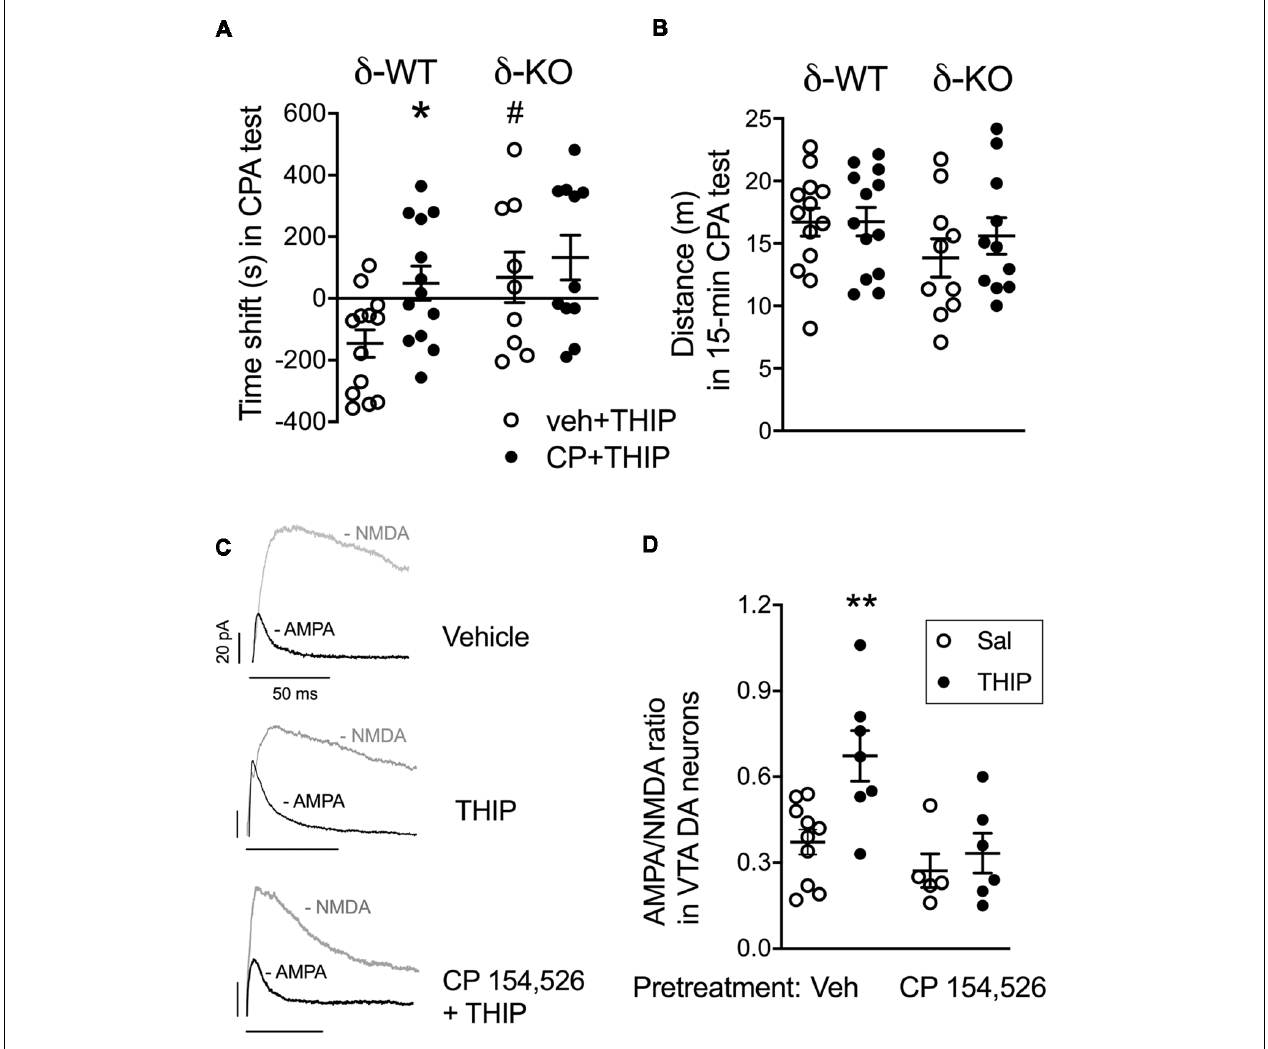
FIGURE 2 | Pretreatment with corticotropin-releasing factor receptor 1 (CRF 1 ) receptor antagonist, CP 154,526, attenuated THIP-induced conditioned place aversion and glutamate neuroplasticity in ventral tegmental area (VTA) dopamine (DA) cells. (A) Vehicle-pretreated δ -WT mice conditioned with THIP expressed place aversion (spent less time with initially non-preferred floor mats) at 48h after the last conditioning session, while those conditioned after CP 154,526 pretreatment failed to express any preference or aversion. The δ -KO mice conditioned with THIP failed to express aversion independent of the pretreatment. (B) Locomotor activity during the final test trial. Scatter plots with means ± SEM, n = 10–12. ∗ p < 0.05 for the difference between treatments within the same genotype; # p < 0.05 for the difference between genotypes after the same treatment (ANOVA with Bonferroni test). (C) Examples of α -Amino-3-hydroxy-5-methyl-4-isoxazole propionic acid (AMPA) and N-methyl-D-aspartate (NMDA) receptor-mediated current traces recorded 24 h after treatment with vehicle + saline, vehicle + THIP (6mg/kg) and CP 154,526 (10 mg/kg) + THIP in transgenic Tyrosine Hydroxylase-EGFP mice. Scale bars represent 20 pA and 50 ms. (D) Averaged data show THIP-induced the increase of AMPA/NMDA (A/N) ratios in VTA DA neurons for mice pretreated with vehicle, but not for those pre-treated with CP 154,526. Scatter plots with means ± SEM, n = 5–7. ∗ p < 0.05, ∗∗ p < 0.01 (ANOVA with Bonferroni